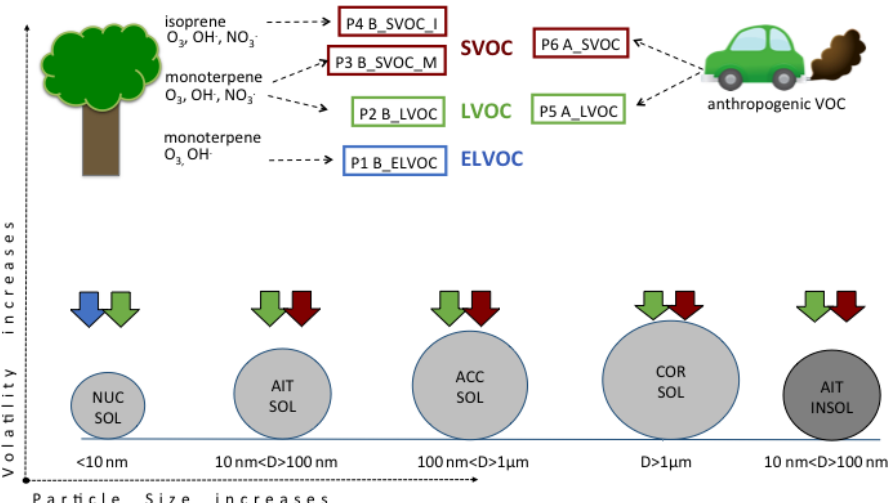
Figure 1. Schematic showing the SOA formation scheme in GLOMAP-mode and the six oxidized VOCs (products of photochemical ox- idation of emitted VOCs that eventually produce SOA) whose concentrations are perturbed in this study. The six oxidized VOCs repre- sent three volatility categories – extremely low-volatility organic compounds (ELVOCs, blue), low-volatility organic compounds (LVOCs, green), and semi-volatile organic compounds (SVOCs, red). Prefix “A” indicates precursor gases of anthropogenic origin and “B” indi- cates biogenic origin. The schematic shows the precursor gases and oxidants that react to produce these ox-VOCs, their relative volatility (ELVOC < LVOC < SVOC), and the mechanism (nucleation for ELVOCs, kinetic condensation for LVOCs, and mass-based partitioning for SVOCs) by which they add to the condensed phase (represented here by the five modes: nucleation soluble, Aitken soluble, accumulation soluble, coarse soluble, and Aitken insoluble modes). Table 1. List of oxidized VOCs implemented in this study, the volatility class they represent, whether produced from biogenic or anthro- pogenic sources, how they take part in atmospheric SOA formation, parent VOC, and oxidants that react to produce each ox-VOC. MT stands for monoterpene, IP stands for isoprene, and CO stands for carbon monoxide indicating anthropogenically sourced VOC. ox-VOC Volatility Nature of source Role Parent VOC Oxidants B_ELVOC Extremely low biogenic nucleation α -pinene biogenic kinetic